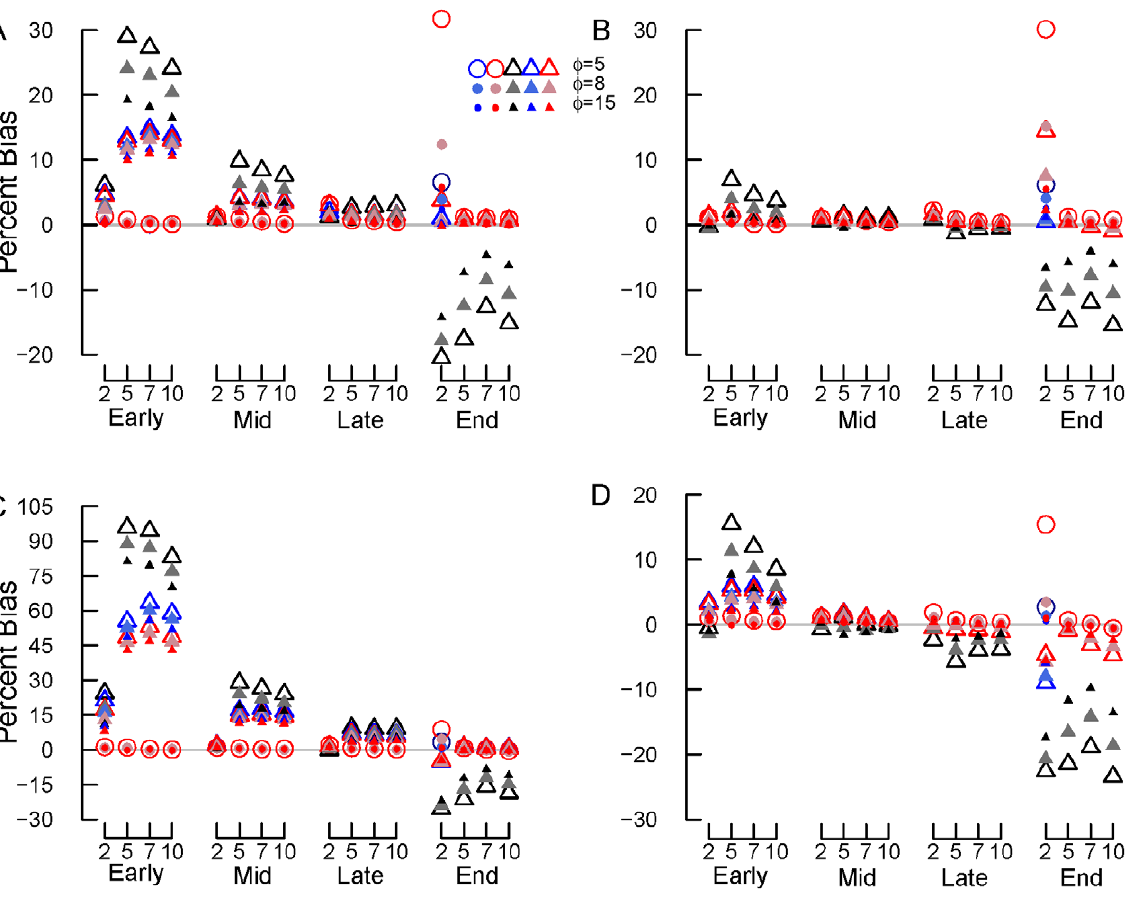
Figure 4. Percent bias for beta-distributed errors plus normal errors. (A) standard deviation ( s )=0.0125 (option 3a) and SV transformation, (B) s =0.0125 (option 3a) and REP transformation, (C) s =0.05 (option 3b) and SV transformation, (D) s =0.05 (option 3b) and REP transformation. Early, mid, late and end are early, mid, late and end stage decomposition simulations. The numbers 2, 5, 7 and 10 are the numbers of measurements used in each simulation. Blue circles=NLS, Red circles=Normal ML, gray/black circles=Beta ML. In most cases, nls=Normal ML so that the red circles cover the blue circles. Gray lines show 0% bias.